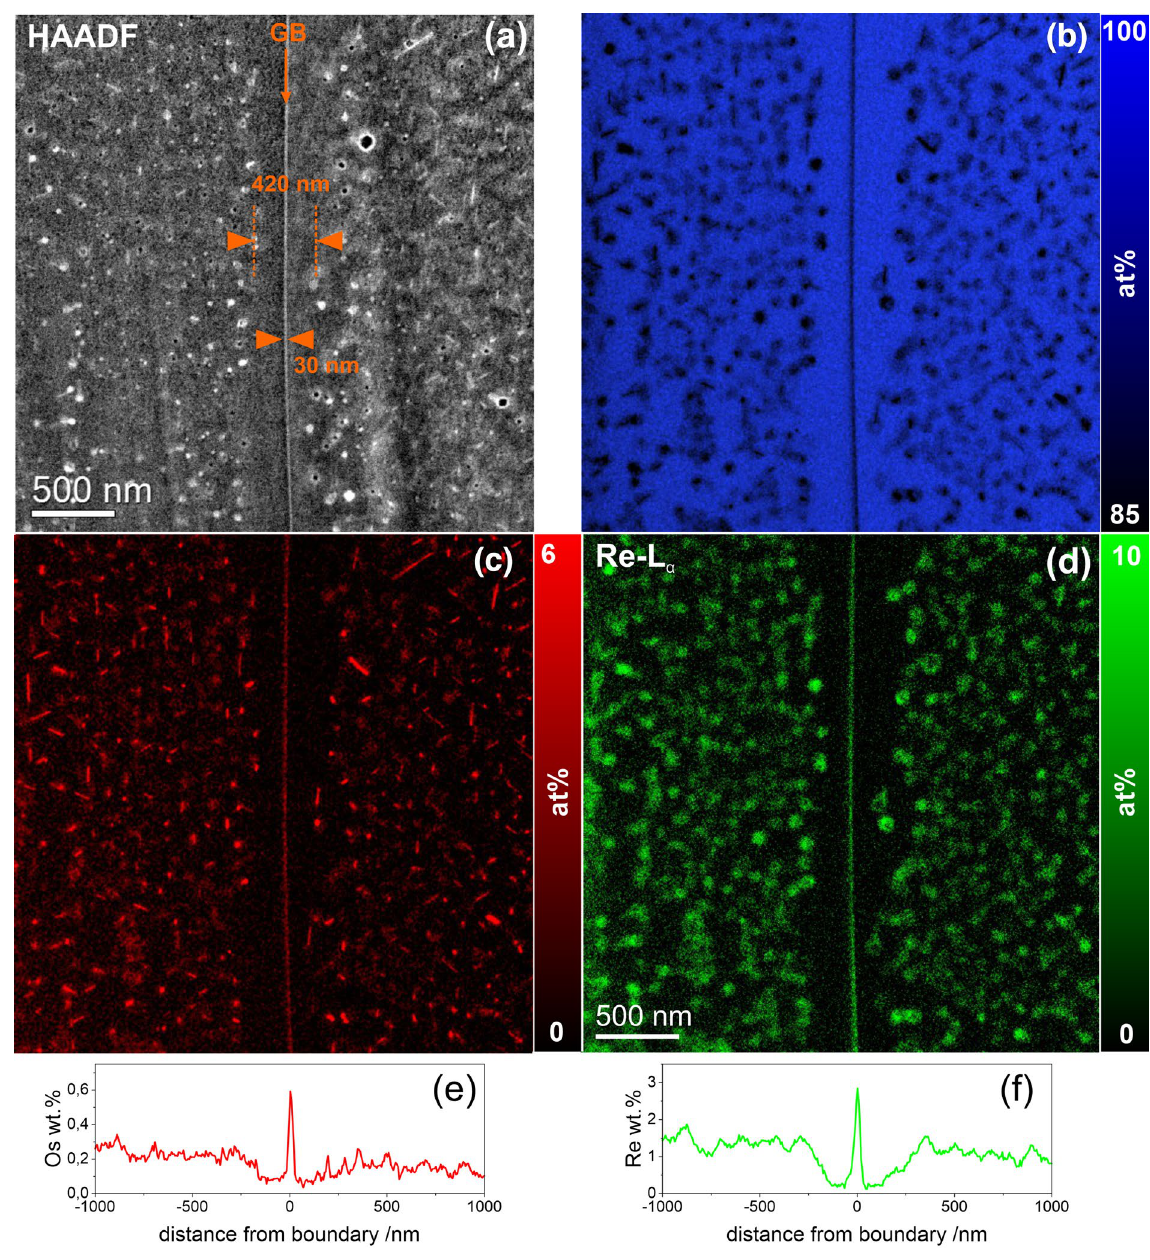
Figure 6. STEM-EDX mapping near GB. ( a ) STEM-HAADF image with marked position of GB. Elemental maps of ( b ) W, ( c ) Os, and ( d ) Re display the location of elements with respect to the sample morphology. The profiles in parts ( e ) and ( f ) indicate the distribution of the Os and Re concentration near the